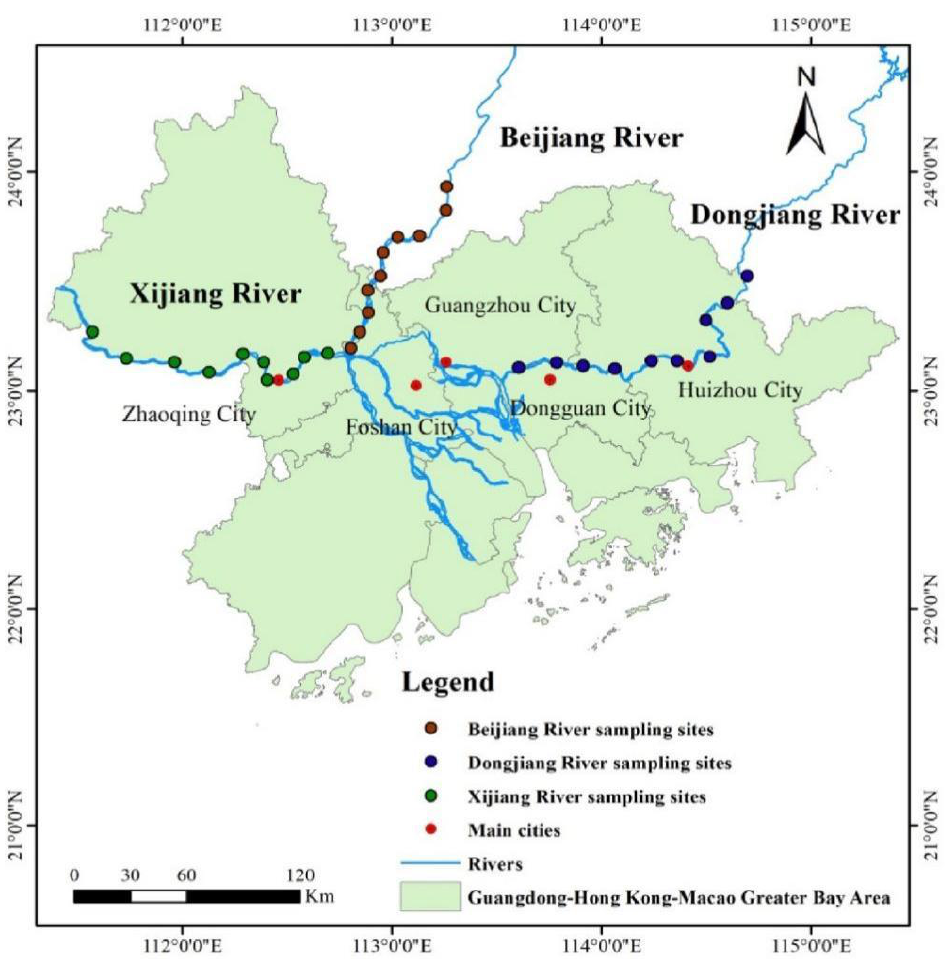
Figure 1. Location of the research site.